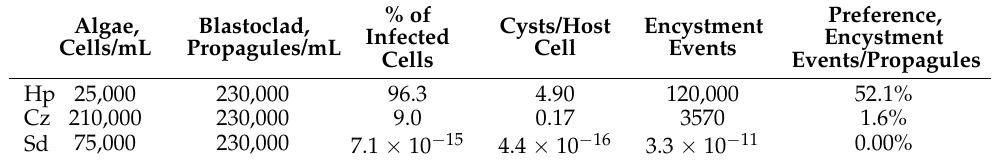
Table 1. Preference test in a mixed algae culture. We measured the number of encystment events after 9 h, in a mixed algae culture containing the three microalgae (in a 10 mL flask), offering the same algal surface area to the inoculated parasite propagules. Hp: H. pluvialis , Cz: C. zofingiensis and Sd: S. dimorphus